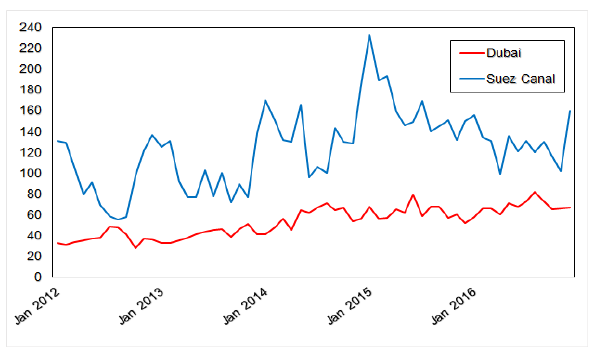
Figure 5 Variation of counted AIS’ positions per bin in Dubai and Suez Canal port locations